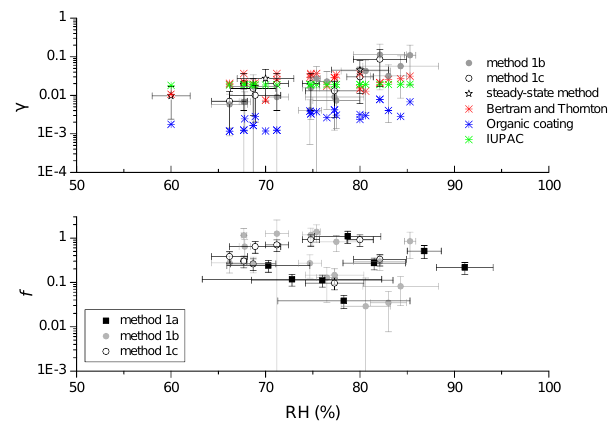
Figure 8. Values of γ and f derived via methods 1a–1c and the steady-state analysis during PARADE. The vertical error bars rep- resent total uncertainty including errors associated with the mea- surement of concentrations of trace gases and particle surface areas. The horizontal error bars are the standard deviation of the relative humidity over the measurement period (1–3h for methods 1b and 1c and up to 8h for method 1a). The red stars represent uptake co- efficients calculated using the Bertram and Thornton (2009) param- eterization, the blue stars include the impact of an organic coating (Anttila et al.,